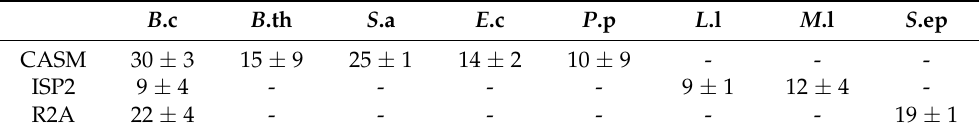
Table 1. Diameter of the clear zone (mm) of crude fermented extract of S. huasconensis D23.